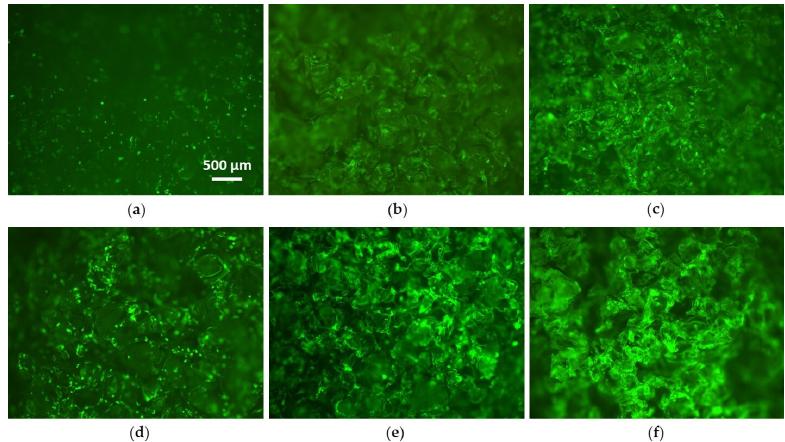
Figure 8. Fluorescence microscopy images of actin cytoskeleton of Saos-2 cells grown ( a ) for 17 and ( d ) 88 h on control; ( b ) for 17 and ( e ) 88 h on H 2 O/Mg2.5/absorbent; and ( c ) for 17 and ( f ) 88 h on H 2 /Mg15.8 scaffolds. Atto488 phalloidin was used to observe the actin (green) structure of the cytoskeleton.